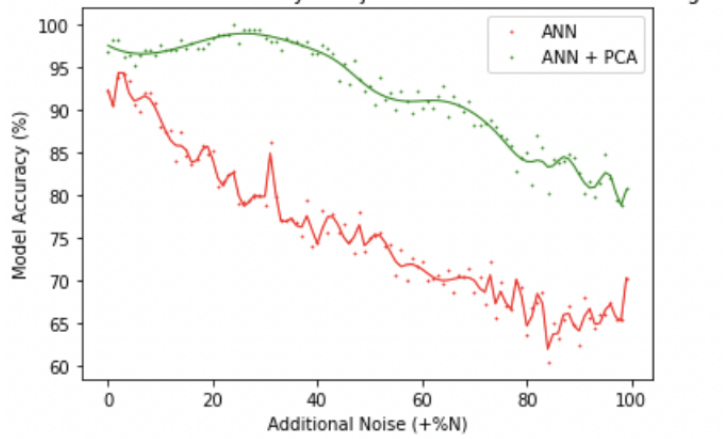
Figure 27. +%Noise response for the cancer patients dataset (Sc =